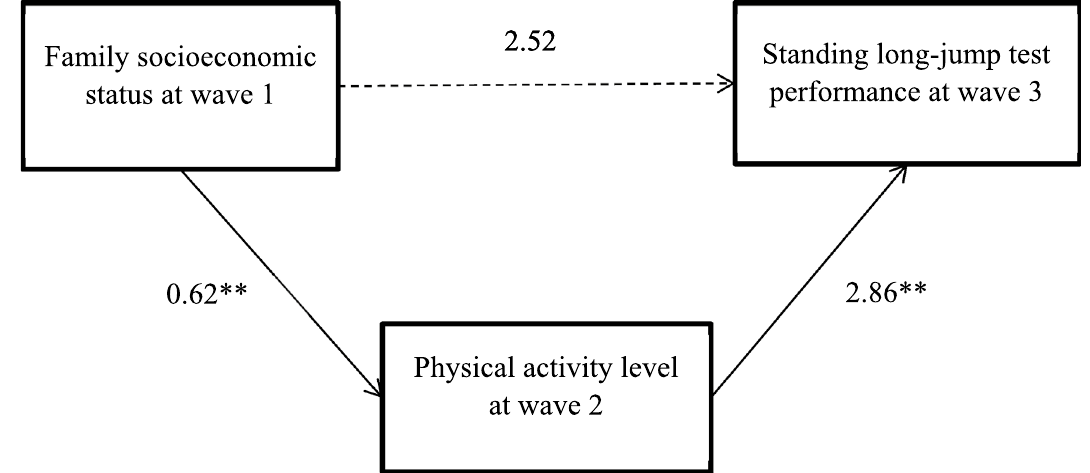
Figure 1. Path model linking family SES at Wave 1 to standing long-jump test performance at Wave 3.